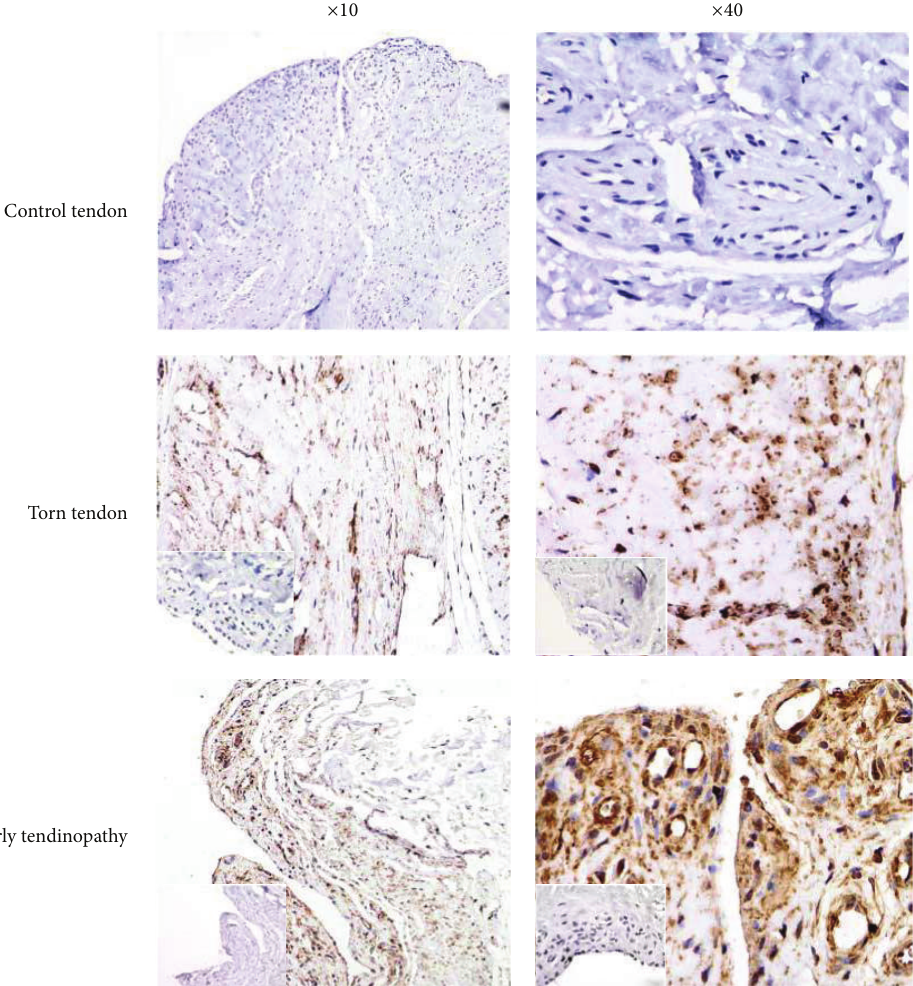
Figure 2: Immunohistochemical staining for IL-21R in human tendinopathy. IL-21R staining from control tendon, torn tendon, and early tendinopathy at × 10 and × 40 magnification stained for Isotype IgG in bottom left